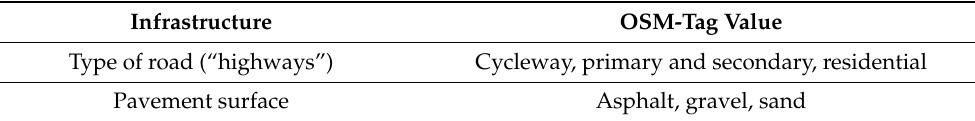
Table 2. Road types and surfaces.